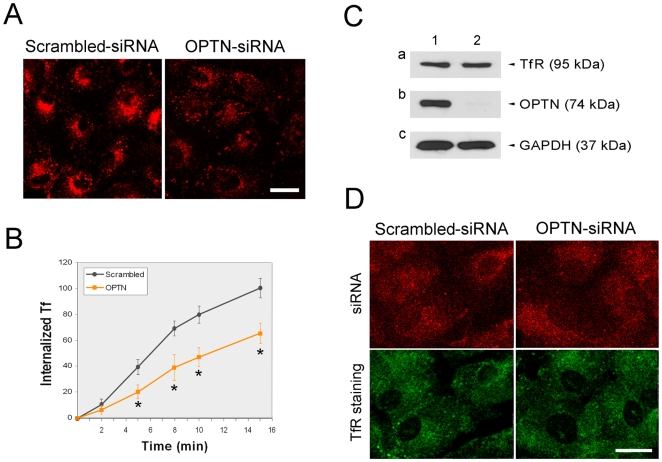
Knockdown of the endogenous optineurin inhibits Tf uptake but has little effect on the TfR level or distribution in RPE cells.(A) Fluorescence images of RPE cells transfected for 48 h with 50 nM generic scrambled control or optineurin (OPTN) siRNA after a 15-min uptake of TR-Tf (in red). Scale bar, 20 µm. (B) Quantification of Tf uptake in scrambled (dark gray filled circles)- and OPTN siRNA-(orange squares) transfected cells. Fluorescence intensity of 7 randomly selected 20× fields at 0-, 2-, 5-, 8-, 10-, and 15-min time points was measured and divided by the number of cells. The internalized TR-Tf at each time point was expressed as percentage relative to that of the 15-min uptake in scrambled siRNA-transfected cells. Data (mean ± SD) presented are representative of three independent experiments. *, P<0.0001 compared to scrambled controls. (C) Expression level of endogenous TfR and optineurin in optineurin siRNA-treated cells. The cell lysates were immunoblotted with anti-TfR, anti-optineurin (OPTN), and anti-GAPDH. The TfR level was not altered while the optineurin knockdown (lane 2) was confirmed. Anti-GAPDH antibody was used to assess protein loading. (D) RPE cells were transfected with scrambled or OPTN siRNA along with Cy3-labeled control siRNA. Cy3 (red) fluorescence was seen in nearly all cells (top panel), indicating that the siRNA transfection efficiency was >95%. These cells were immunostained with anti-TfR (green, bottom panel) for TfR distribution. No alteration was observed. Scale bar, 20 µm.